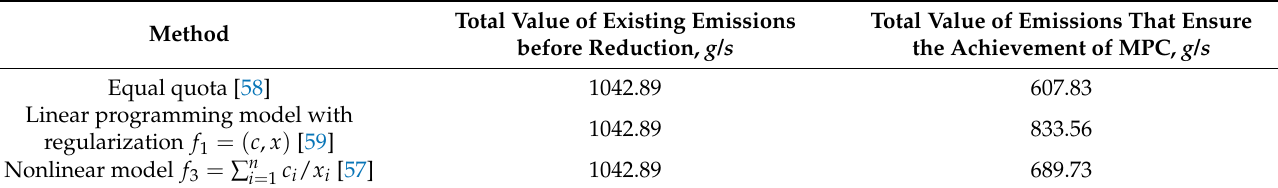
Table 9. Existing cumulative emission and cumulative emission value (MPE) to achieve